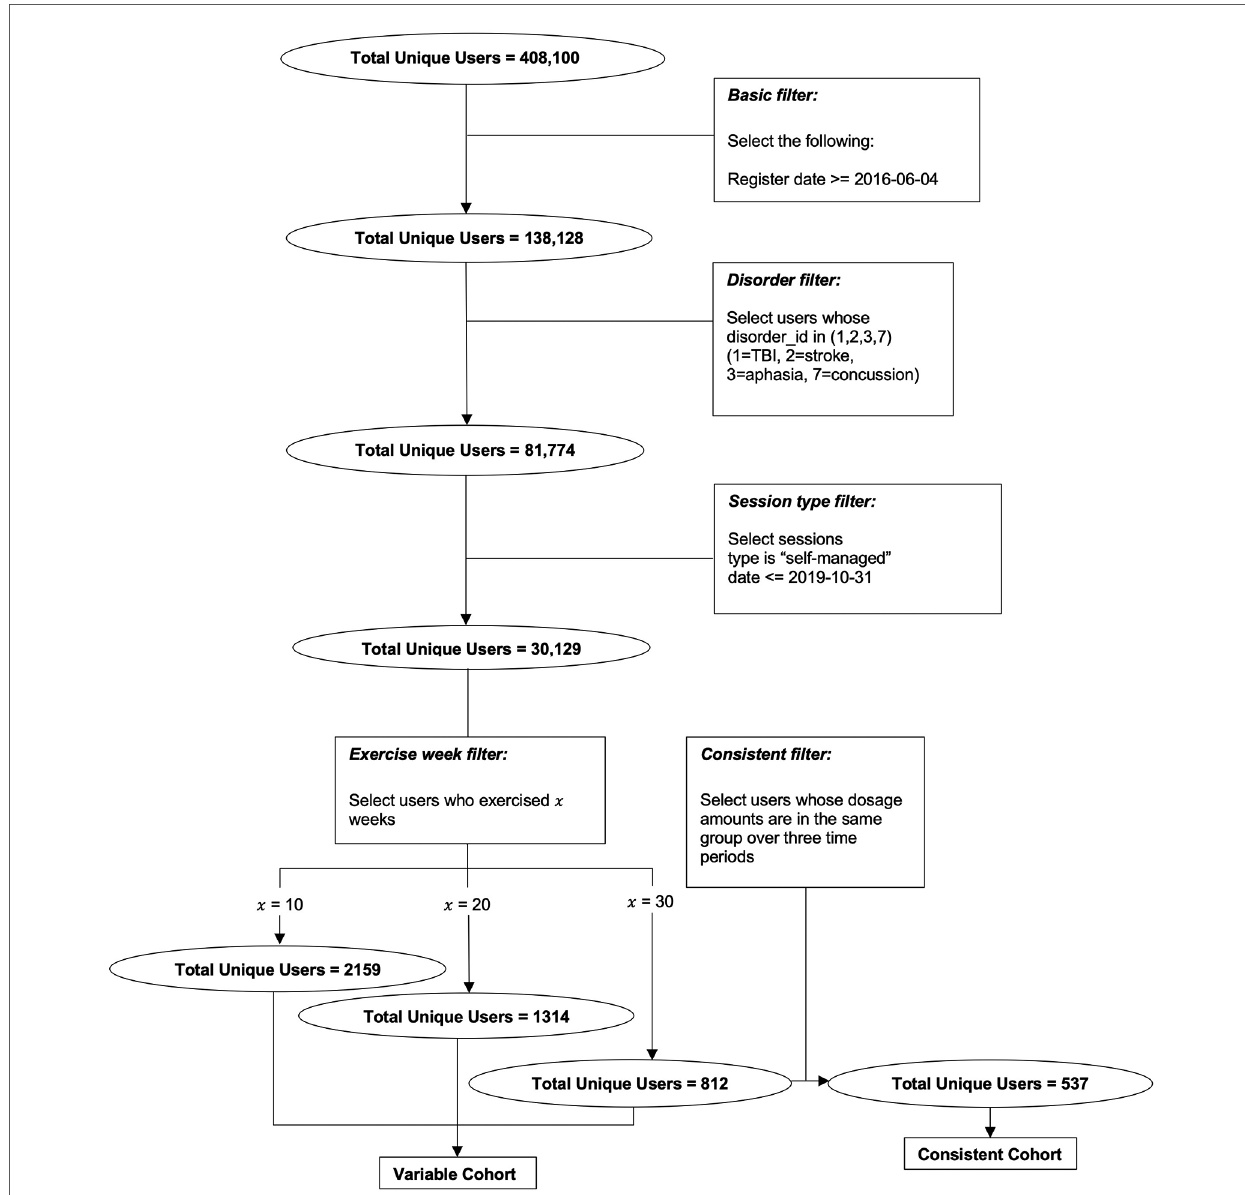
FIGURE 1 Flow chart of the data fi ltering procedure that results in the two cohorts for which analysis 1 and 2 are conducted,